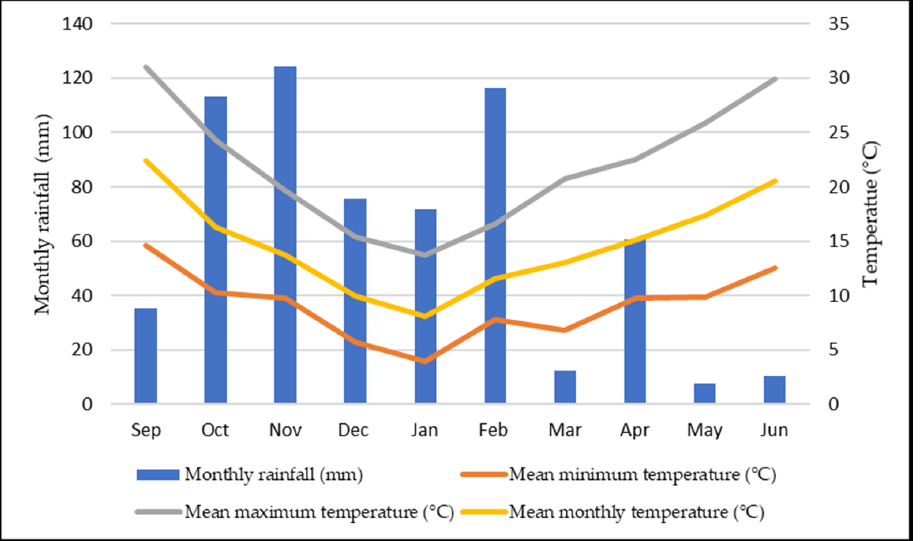
Figure 5. Thermopluviometric graph for Mitra station (Évora) between September 2020 and June 2021.